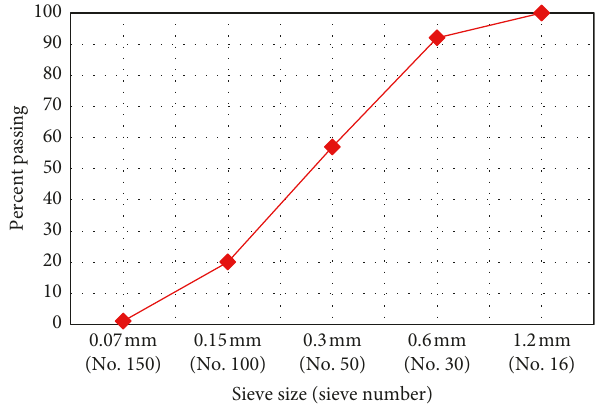
Figure 2: Grading curve of fine